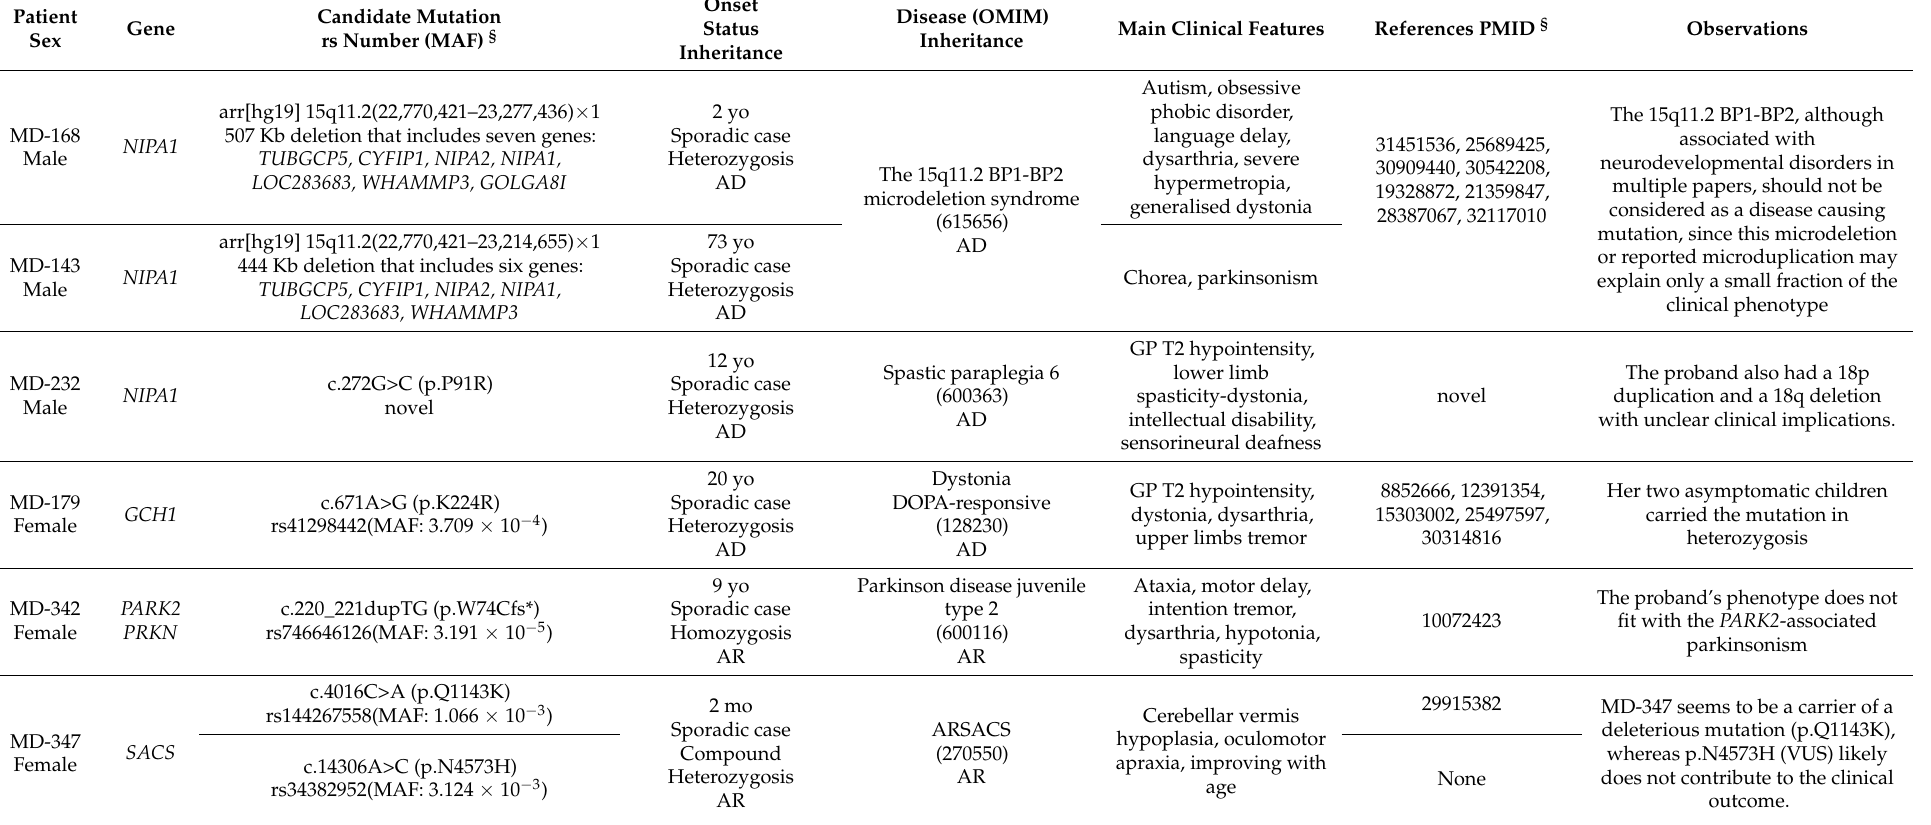
Table 3. Genetics and main clinical features of controversial